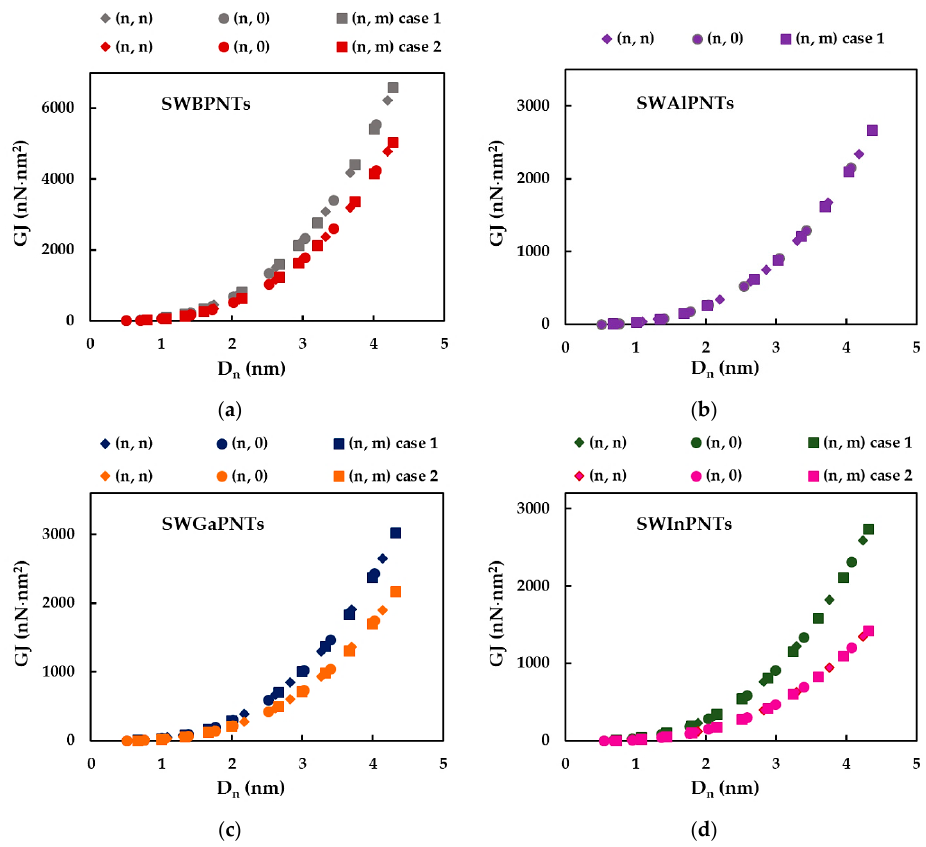
Figure 8. Evolution of torsional rigidity, GJ, as a function of the nanotube diameter, D n , for: ( a ) SWBPNTs; ( b ) SWAlPNTs; ( c ) SWGaPNTs; and ( d ) SWInPNTs.